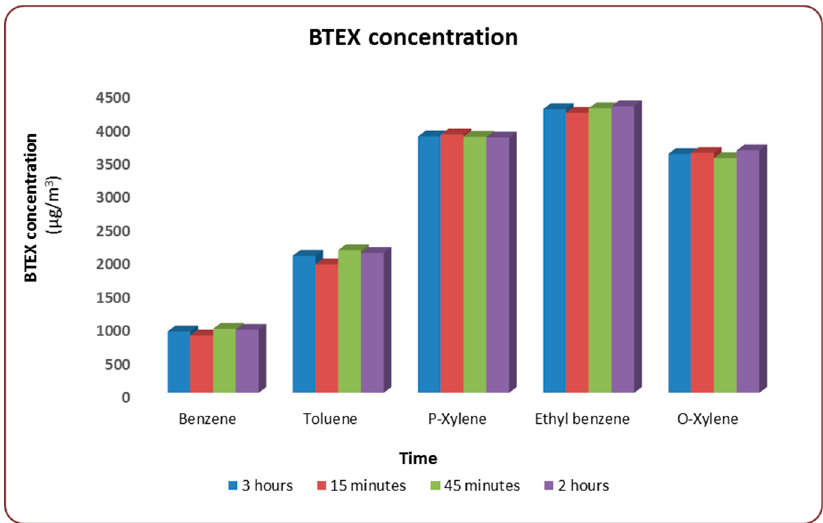
Figure 2. Time series of benzene, toluene, ethylbenzene, and xylenes (BTEX) concentration for a 3-hour combustion cycle.